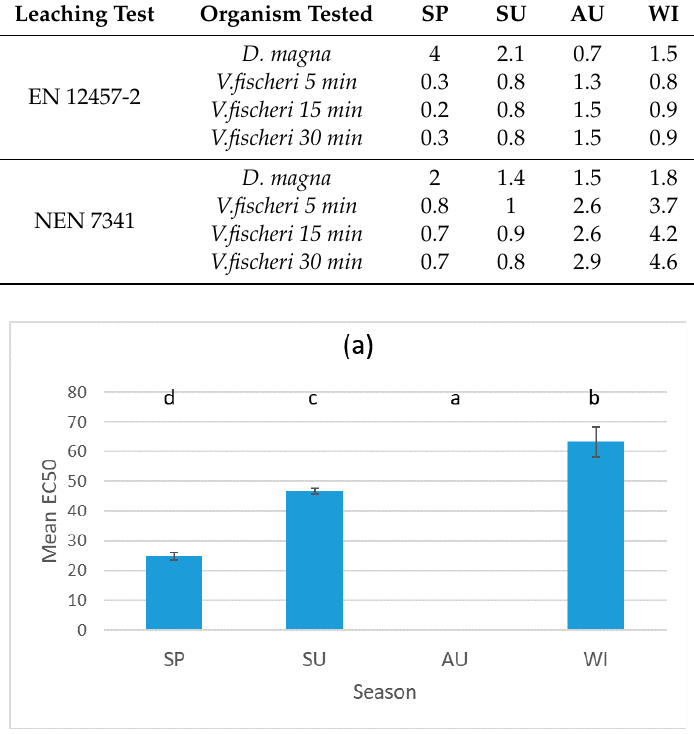
Table 1. Physicochemical parameters on the leachates of the four sludges tested